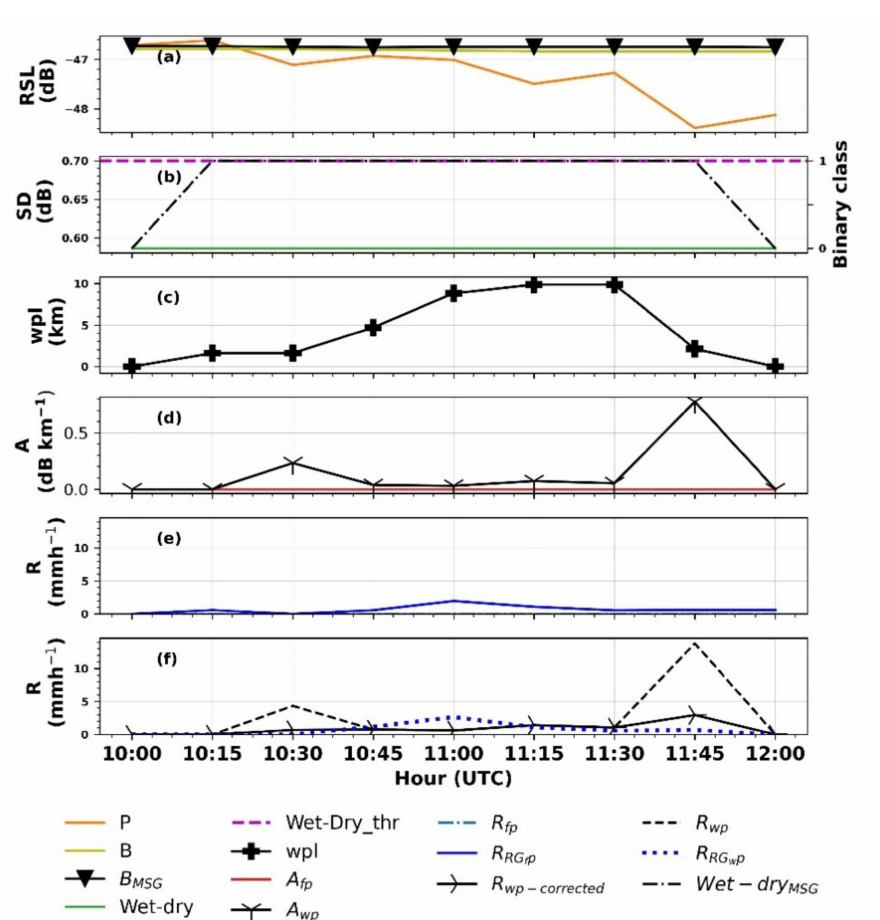
Figure 7. ( a – f ) As in Figure 3 but for 15 min interval rain events of 15 May 2018.